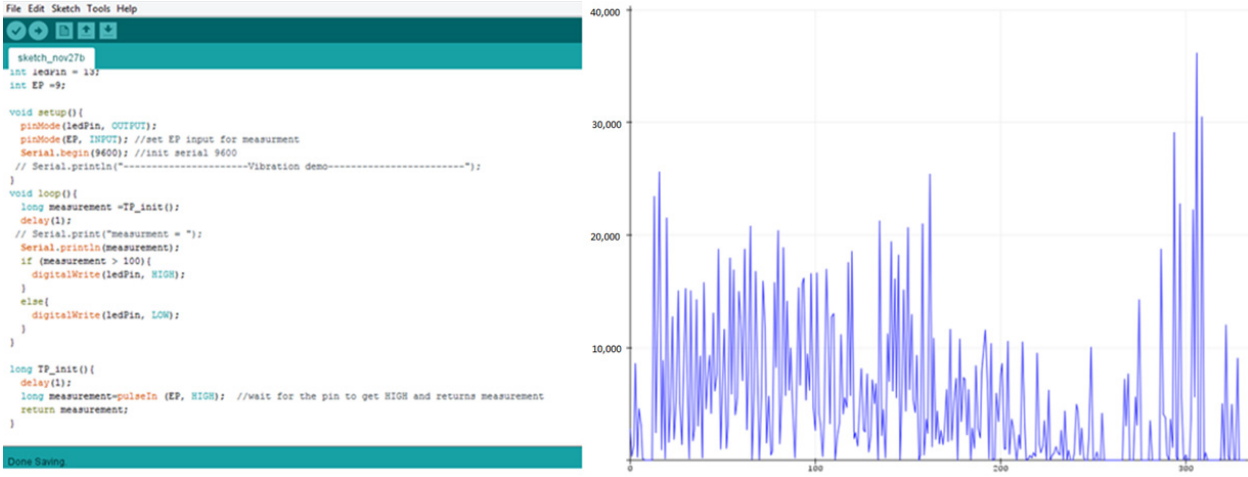
Figure 2. Vibrational frequency in machining of SS304 steels.